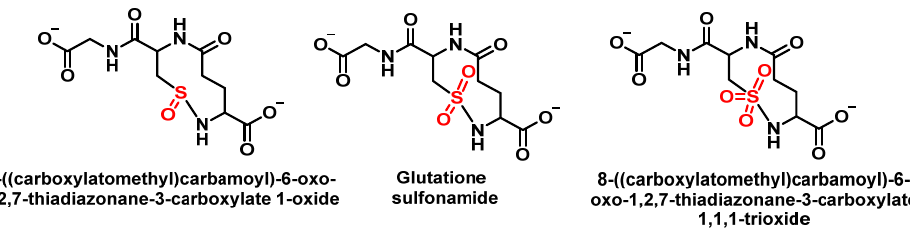
Figure 38. Cyclic amides formed in the reaction of GSH with HOCl.